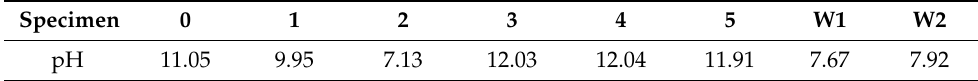
Table 8. The pH of the river water and concrete filtrates after 24 h of dynamic leaching. Specimen 0 1 pH